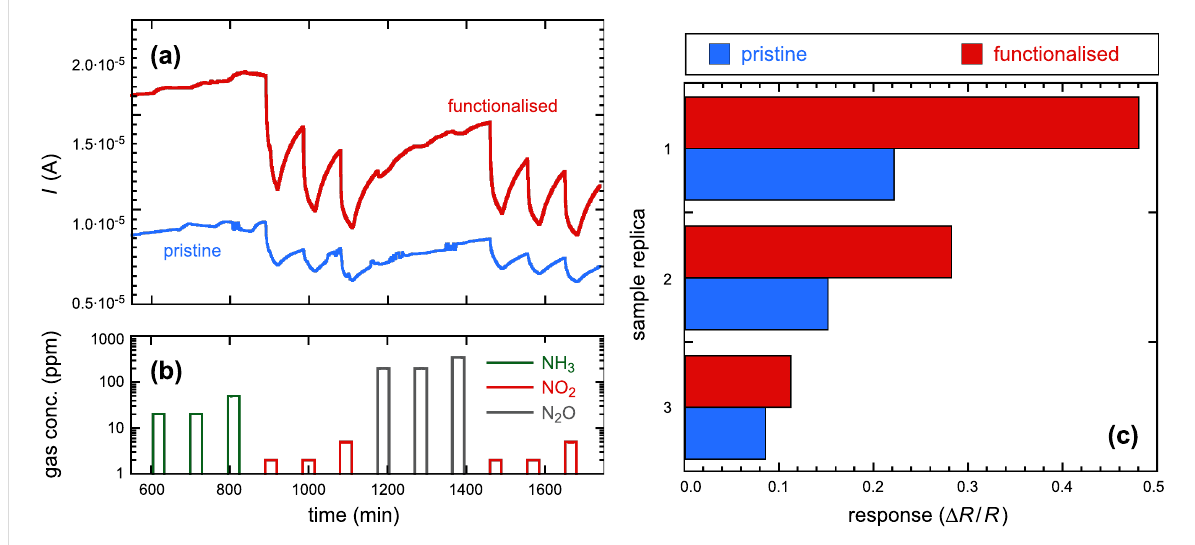
Figure 7: Dynamic response of the same ZnO nanowire sensor, (a) before and after coating with ZnO nanoparticles and THMA; (b) during exposure to different concentrations of NH 3 , N 2 O and NO 2 ; and (c) response Δ R / R exhibited by three sensor replicas before and after THMA functionalization to 2 ppm of NO 2